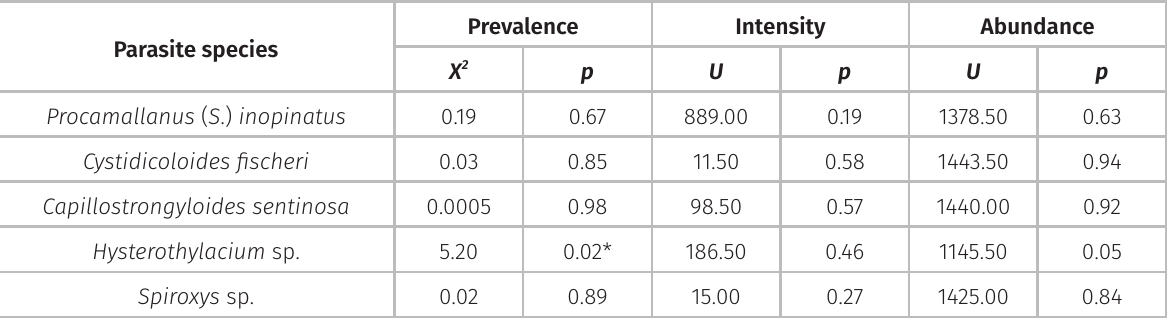
Table VII. Analysis of parasite indexes under possible influence of the total length of Pygocentrus piraya from Três Marias reservoir, upper São Francisco river, state of Minas Gerais, Brazil. Parasite species